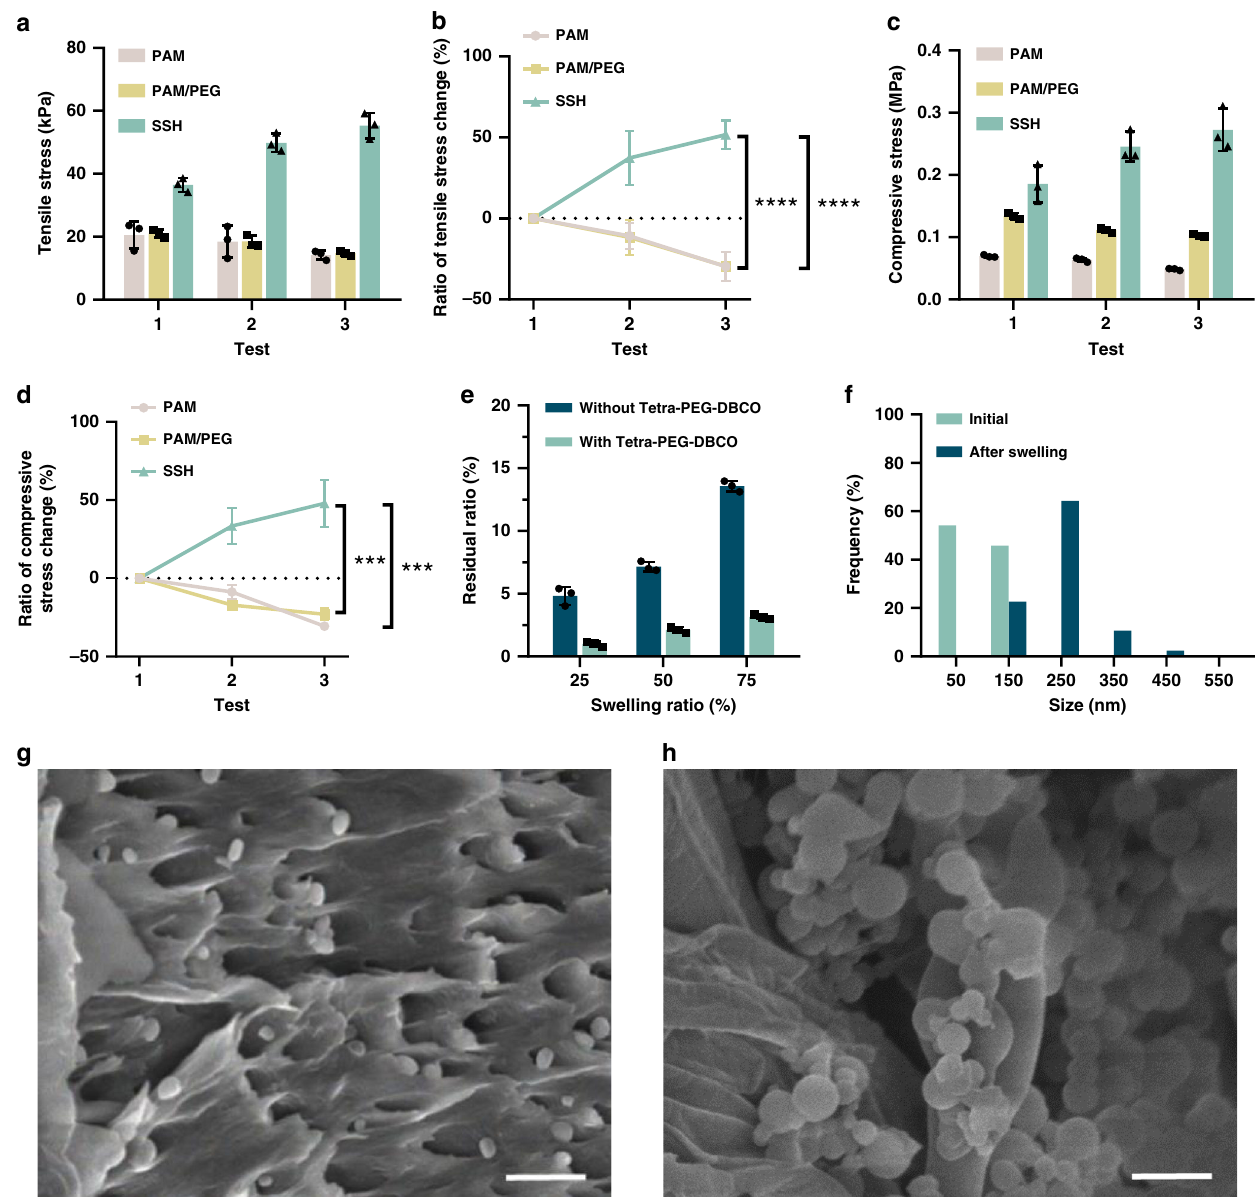
Fig. 4 Swelling-triggered transmembrane transport and click reaction. a Tensile stress and b variation of tensile stress under different tensile conditions. (1) direct test; (2) test after prestretching at 100% strain for 5 min; (3) test after prestretching at 200% strain for 5 min. c Compressive stress and d variation of compressive stress at 70% strain under different compression conditions. (1) direct test; (2) test after compression at 70% strain for 5 min; (3) test after compression at 70% strain for 10 min. e Relationship between released yet unreacted N3-PEG3-N3 and swelling ratio of the gels with or without Tetra-PEG-DBCO. f Average size of the liposomes embedded in the gels before and after swelling, respectively. Scanning electron microscopy (SEM) images of the lyophilized swelling-strengthening hydrogels (SSHs) ( g ) before and ( h ) after fully swelling. Scale bar, 500 nm. Each test was repeated three times independently with similar results. All error bars represent the mean ± SD ( n = 3 independent experiments). Signi fi cance was assessed using one-way ANOVA with Tukey ’ s multiple comparisons test, giving P values, *** P < 0.001, **** P <